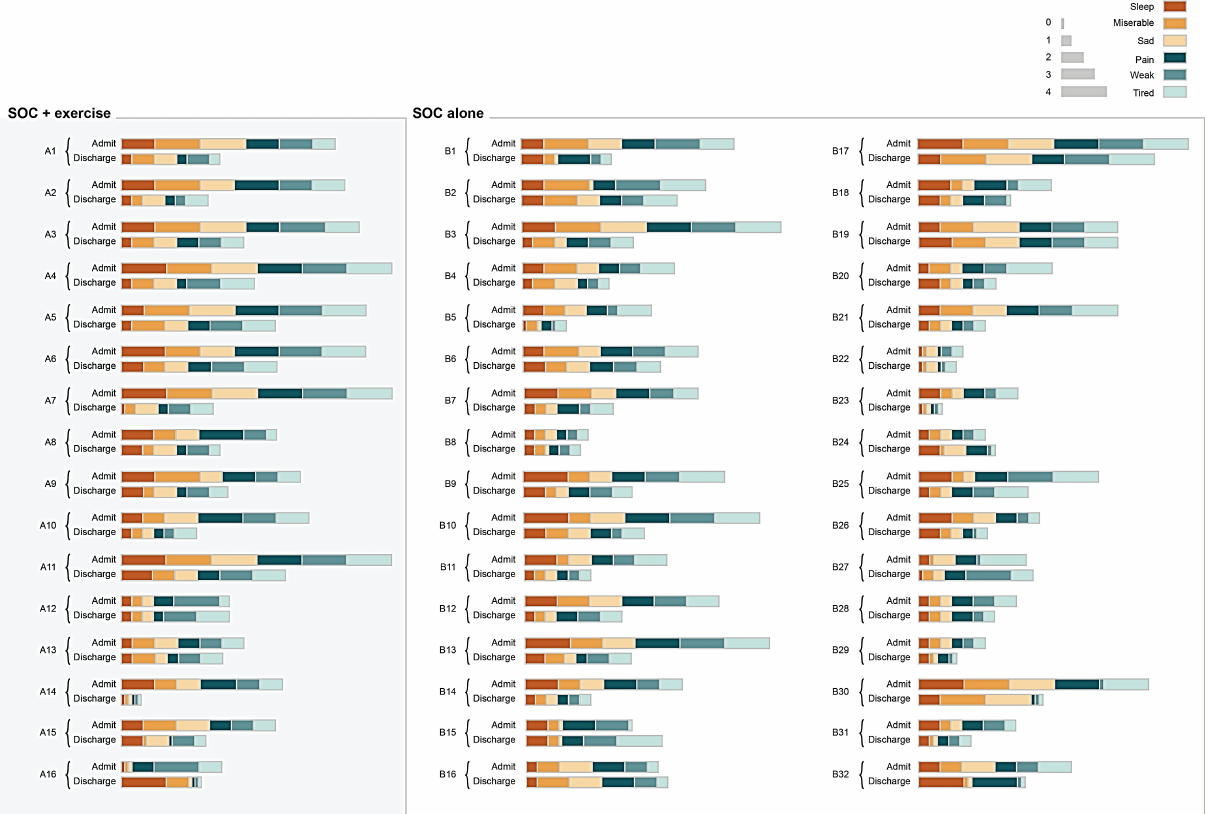
Figure 4. Heatmap illustrating patient-reported physical and mental item scores at admission and at discharge for individual study participants (within their respective groups). Different coloring indicates self-reported physical and mental health items: pain, weak, tired, sleep, misery, and sad. The width of the color corresponds to the score of each parameter (0 = minimal, 4 = maximum). SOC, standard of care; SOC+Ex, standard of care plus